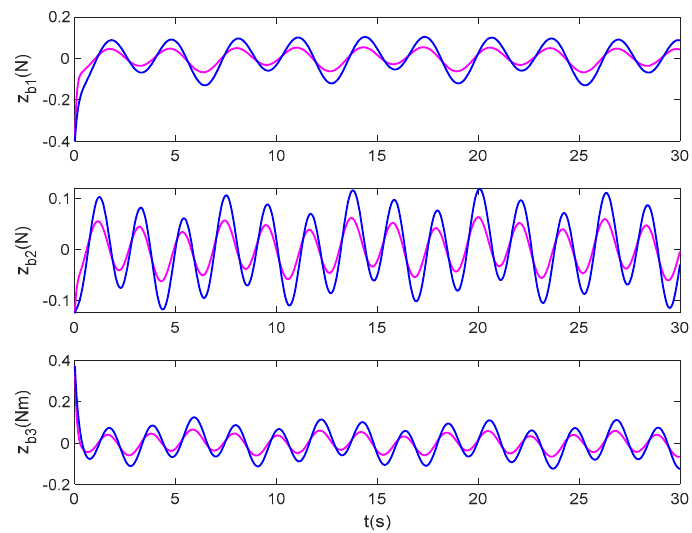
Figure 10. Disturbances estimation error ( β = 0.7).